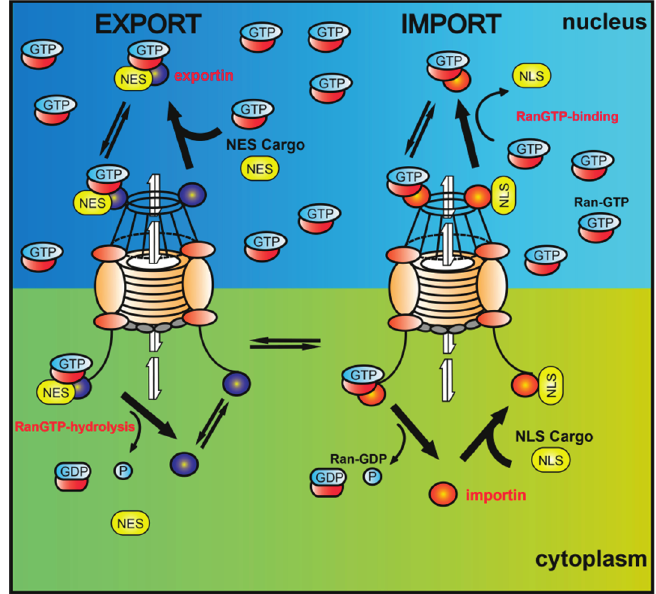
Figure 1. Nuclear import of cargo proteins implicates the recognition of a nuclear localization sequence (NLS) by importin receptors. In the nucleus, importins are dissociated from the cargo through the binding of Ran-GTP. Nuclear guanine-nucleotide exchange factors (GEFs) maintain elevated nuclear Ran-GTP concentration levels. On the other hand, translocation to the cytoplasm is facilitated by a nuclear export sequence (NES), translocation of the export complex to the cytoplasm, the cargo dissociates from the complex by means of GTPase-activating proteins (GAP)-mediated hydrolyzation of Ran-GTP to